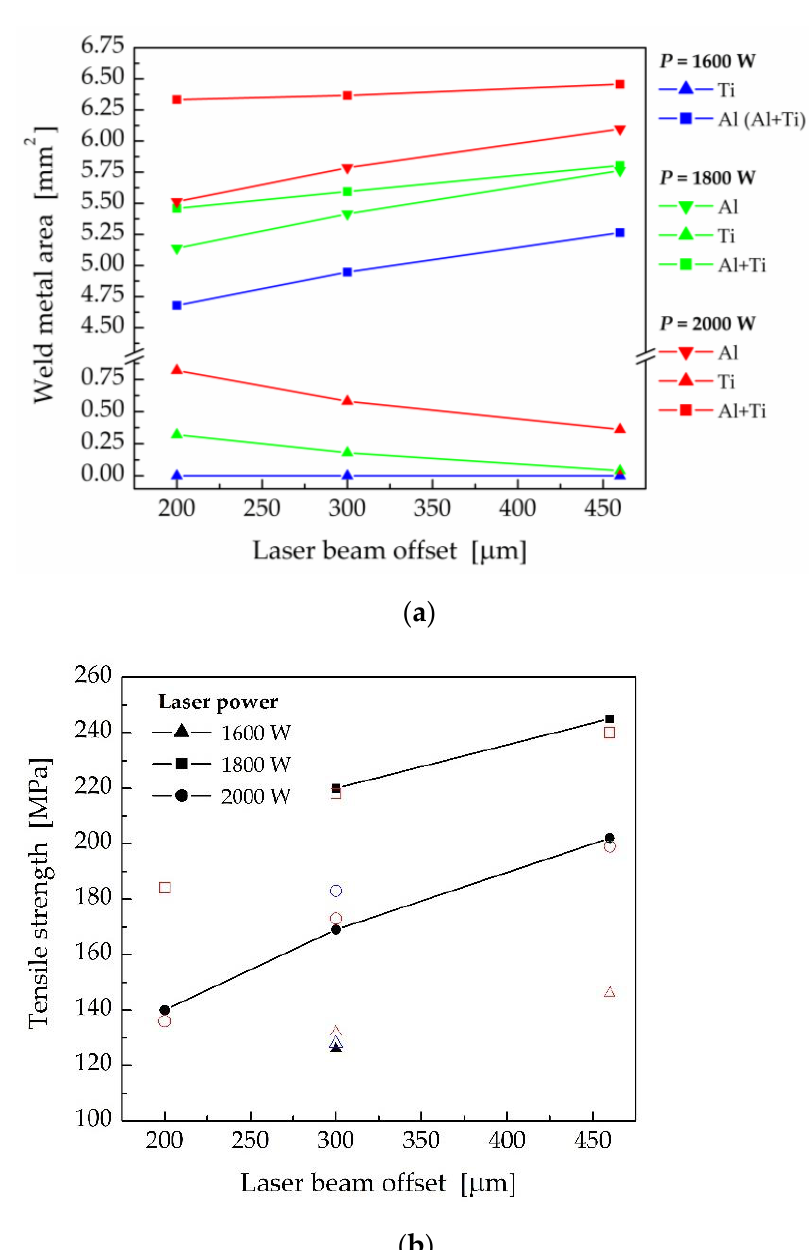
Figure 12. Effect of the laser beam offset ( a ) on the weld metal area and ( b ) on the ultimate tensile strength of the weld joints prepared with different laser powers (red symbols—data according to [93], and blue symbols—data published in [97]).